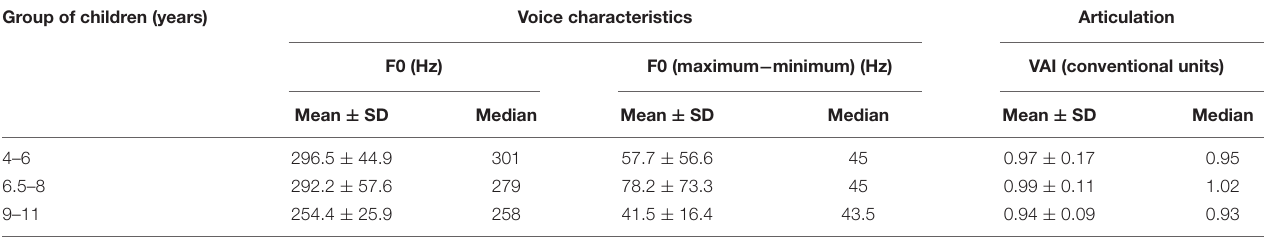
TABLE 1 | Pitch values, pitch variation, and the articulation index (VAI) of stressed vowels in the words of children from three age groups. Group of children (years)